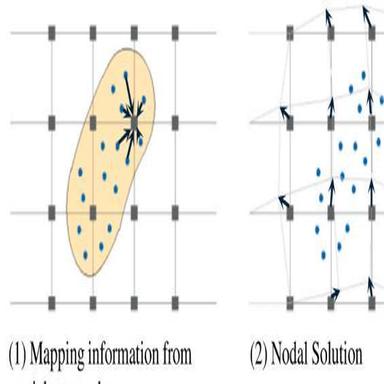
MPM computational cycle, after Soga et al..